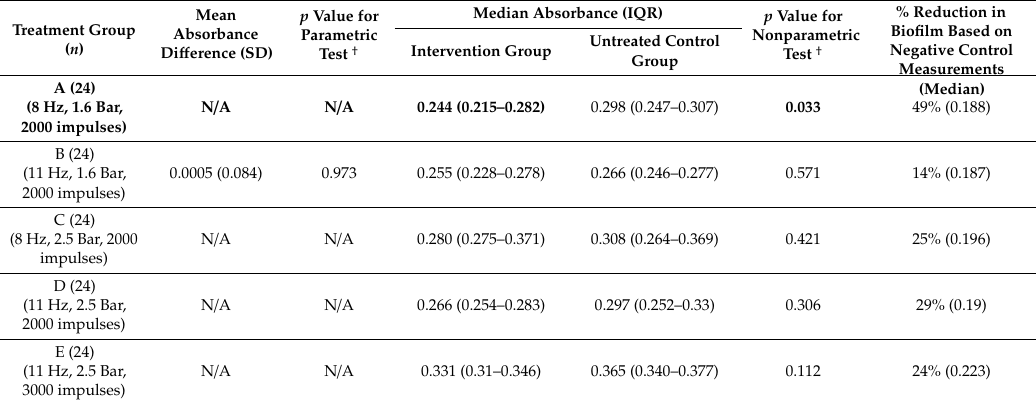
Table 2. Antibiofilm activity of rESWT on C. acnes biofilms.